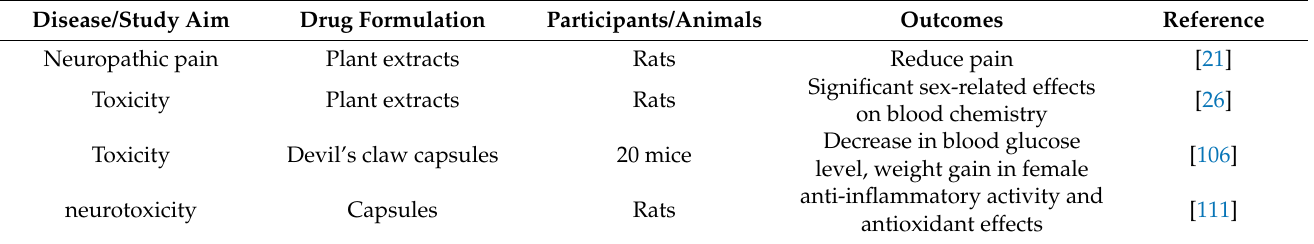
Table 2. Pre-clinical studies of Harpagophytum procumbens.